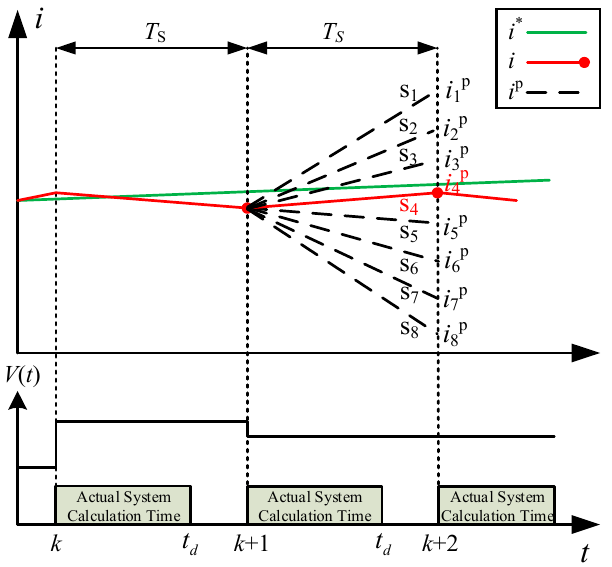
Figure 4. Predictive current control diagram after delay compensation.